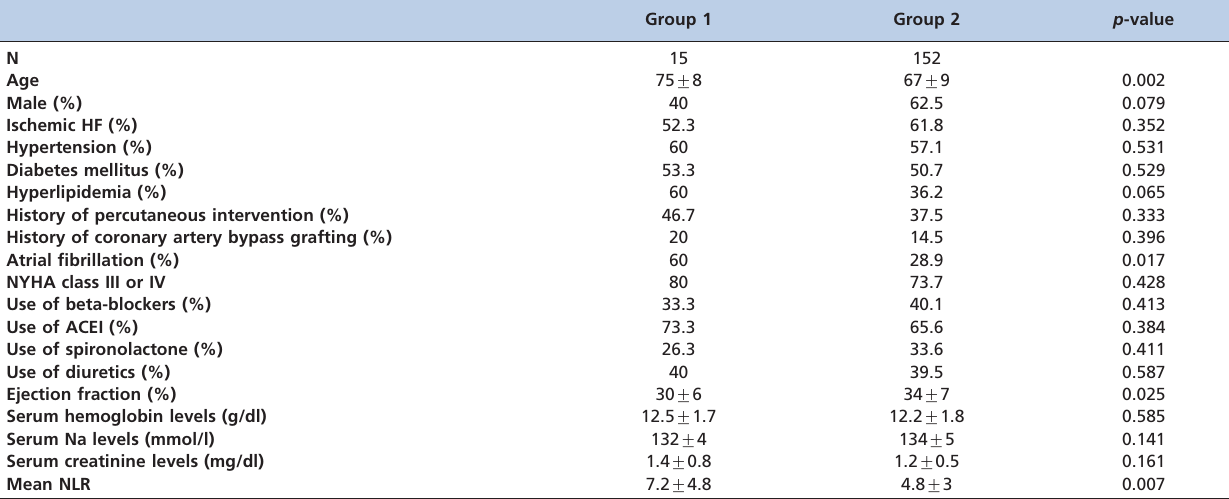
Table 1 - Baseline characteristics of the patients.